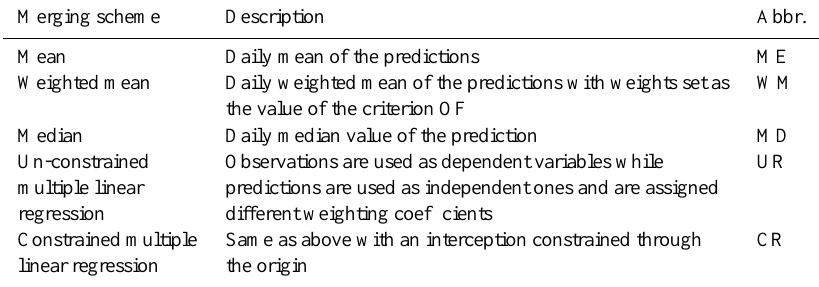
Table 3. Single run results for the different parameter sets. OF=objective function according to Eqs. (1) and (2); PB%=percent bias according to Eq.